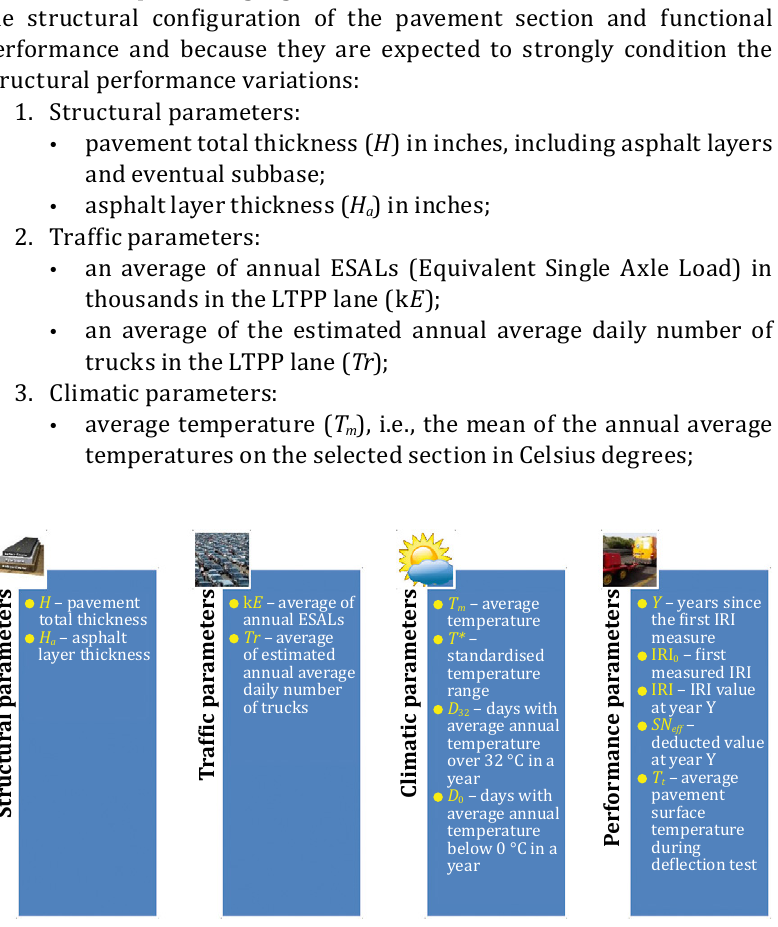
Figure 2. Artificial Neural Network “base